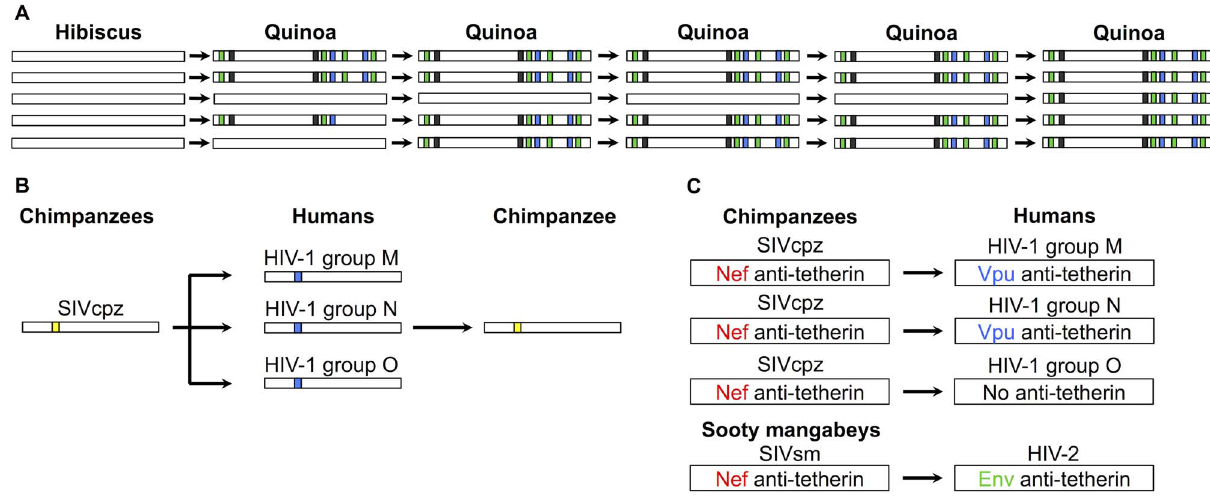
Figure 2. Examples of parallel adaptations following host shifts. (A) Parallel genetic changes in five replicate lines of Hibiscus chlorotic ring spot virus. The white boxes represent the viral genome, and the coloured blocks represent mutations. The virus naturally infects Hibiscus plants, but following five passages in an alternate host, ( Chenopodium quinoa ) the same eight mutations repeatedly occur [57]. (B) Parallel genetic changes in codon 30 of the gag gene (Met to Arg) following three independent transfers of SIVcpz into humans [59]. When a chimp was subsequently infected with HIV-1, the residue reverted back to Met. The coloured blocks represent either a Met (yellow) or Arg (blue) at codon position 30 in the HIV gag gene. (C) Parallel changes in protein function following independent transfers of SIVs from chimpanzees (HIV-1) and sooty mangabeys (HIV-2) into humans. SIV Nef protein does not antagonise tetherin in humans, and so other HIV proteins have evolved the ability to antagonise tetherin [64]. The exception to this is HIV-1 group O viruses, which do not appear to have evolved anti-tetherin activity. In HIV-1 group N viruses the evolution of anti- tetherin activity in Vpu may have come at a cost, as Vpu no longer degrades CD4 receptors to aid the release of viral particles [61]. The coloured gene names in the schematic represent the gene that provides the anti-tetherin function in that host and viral